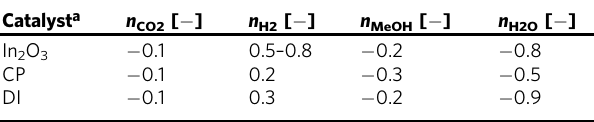
Table 1 Reaction orders of reactants and products Catalyst